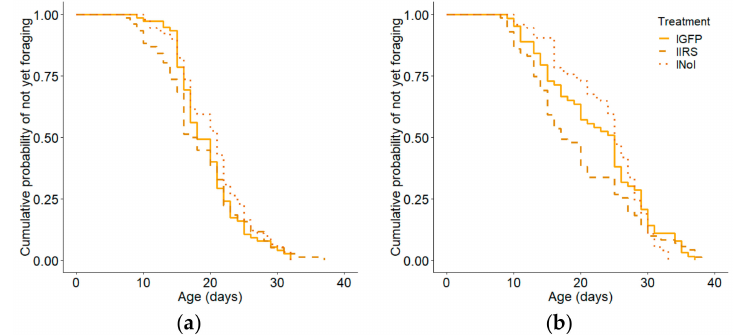
Figure 4. E ff ect of irs knockdown on age of first foraging in low pollen hoarding strain bees in ( a